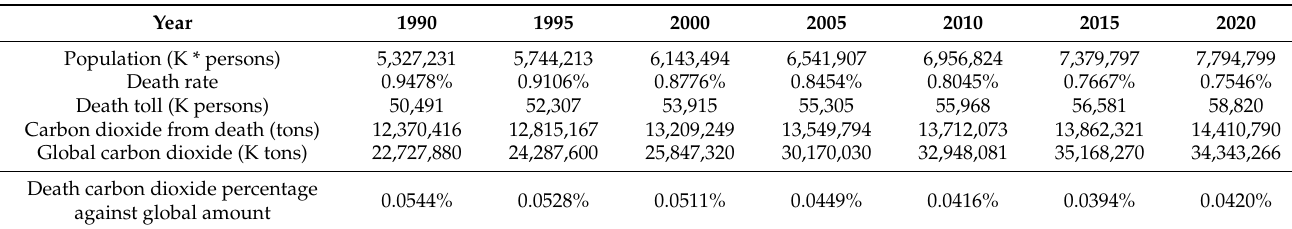
Table 2. Carbon dioxide generated by global deaths, relative to the global carbon dioxide, every five